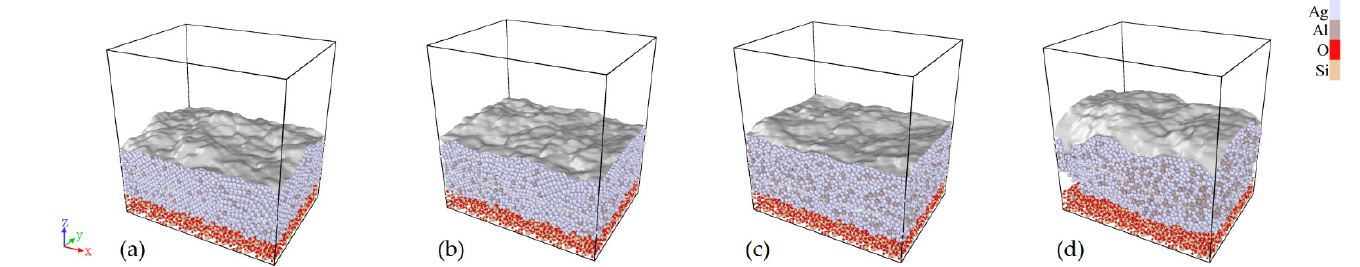
Figure 5. Surface roughness of Al-doped silver films by molecular dynamics simulations. The number of aluminum atoms was set to be ( a ) 1000, ( b ) 2000, ( c ) 4000, and ( d ) 8000, while the number of silver atoms was kept at 20,000.